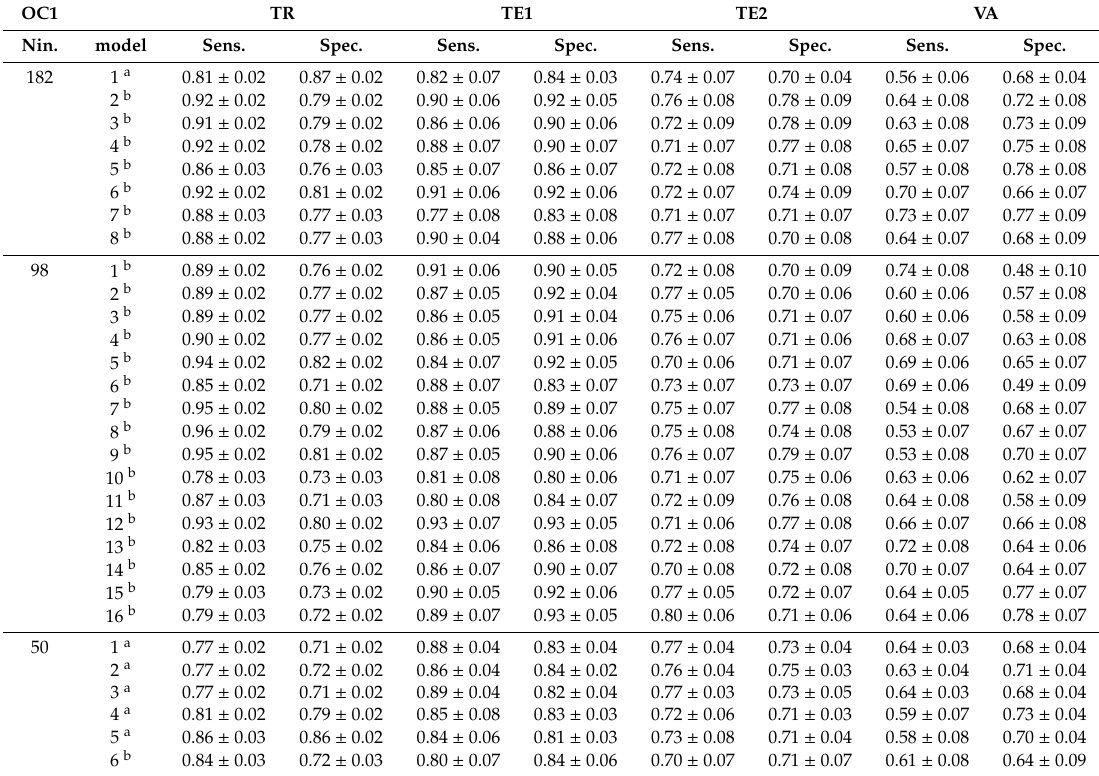
Table 2. Average values of sensitivity and specificity obtained for models optimized using optimization criterion 1. Average values and standard deviations are given for 100 models built using selected descriptors and di ff erent permutations of objects in the training set. OC1 TR TE1 TE2 VA Nin. model Sens. Spec. Sens. Spec. Sens. Spec. Sens. Spec.